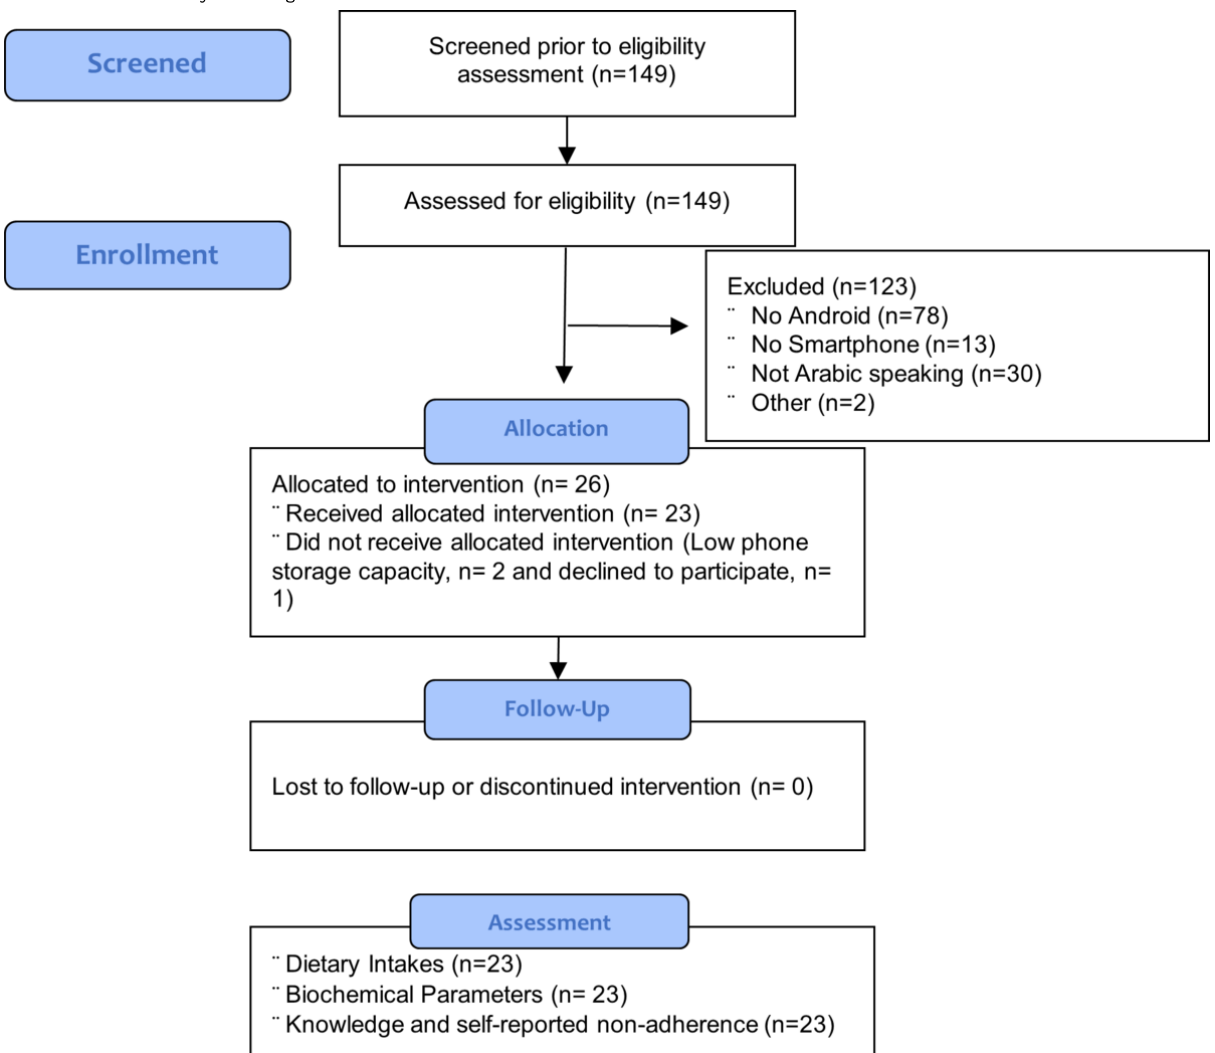
Figure 1. CONSORT study flow